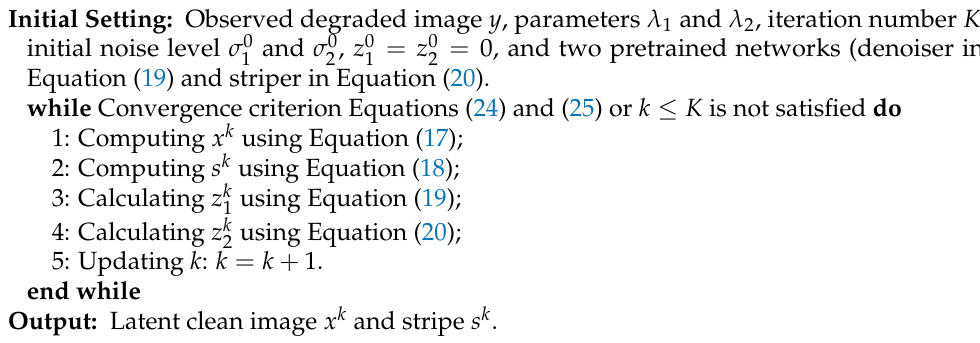
Algorithm 1 The Optimization of Dual Denoiser Driven Convolutional Neural Networks for Remotely Sensed Image